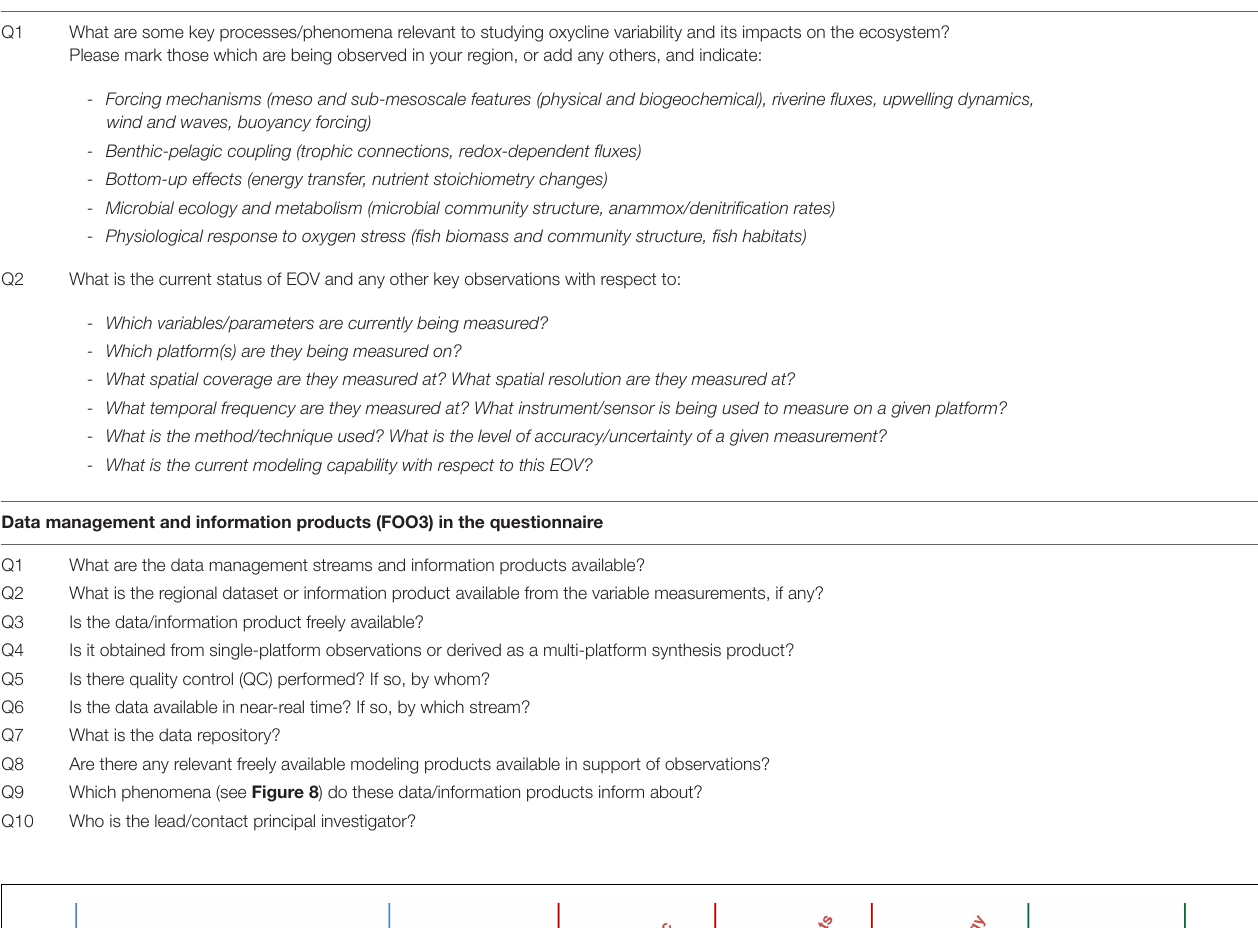
TABLE 3 | List of questions in the questionnaires related to FOO2 and FOO3. Coordination of observing elements (FOO2) in the questionnaire